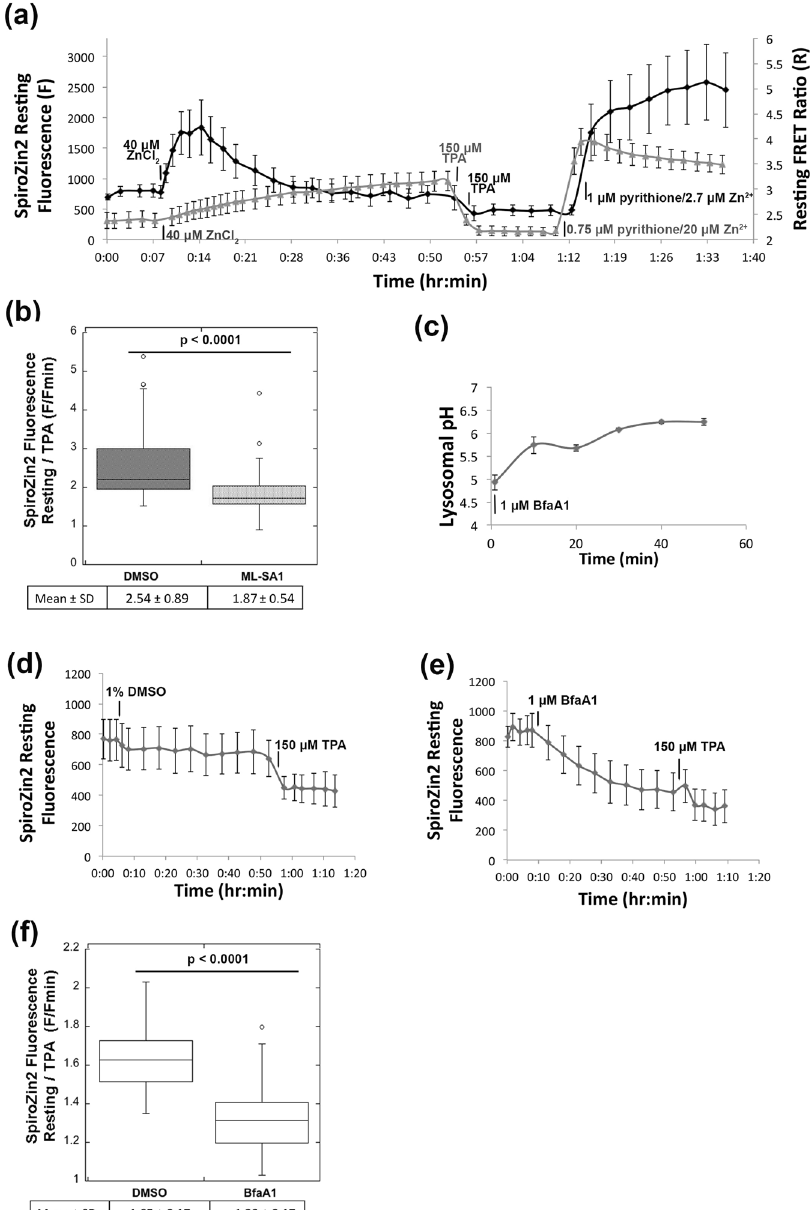
Figure 6. SpiroZin2 reveals changes in lysosomal Zn 2 + upon perturbation. ( a ) The resting fluorescence of SpiroZin2 (black trace, left y axis) and resting FRET ratio (gray trace, right y axis) of ZapCV2 were recorded over time following treatment with 40 μ M ZnCl 2 , 150 μ M TPA and 1 μ M pyrithione/2.7 μ M Zn 2 + (SpiroZin2), 0.75 μ M pyrithione/20 μ M Zn 2 + (ZapCV2). ( b ) Normalized SpiroZin2 fluorescence signal (F/F min ) decreased upon treatment with ML-SA1 compared to the vehicle (DMSO), suggesting a decrease in lysosomal Zn 2 + upon ML-SA1 treatment. F, SpiroZin2 fluorescence at 30 min post ML-SA1 or DMSO treatment. F min , SpiroZin2 fluorescence at 12 min post TPA treatment. n > 52, p < 0.0001, unpaired student’s t-test. ( c ) Lysosomal pH increased upon treatment with 1 μ M bafilomycin A1. SpiroZin2 resting fluorescence was recorded every 5 min for 45 min post treatment with vehicle (1% DMSO) ( d ) or 1 μ M bafilomycin A1 ( e ), followed by treatment with 150 μ M TPA. ( f ) Normalized SpiroZin2 fluorescence (F/F min ) in bafilomycin A1-treated cells is lower than that in DMSO-treated cells. F, the mean of the fluorescence intensities at 40 min and 45 min post treatment with DMSO or bafilomycin A1; F min , the mean of the fluorescence intensities of the last three time points post TPA treatment. n > 24, p < 0.0001, unpaired student’s